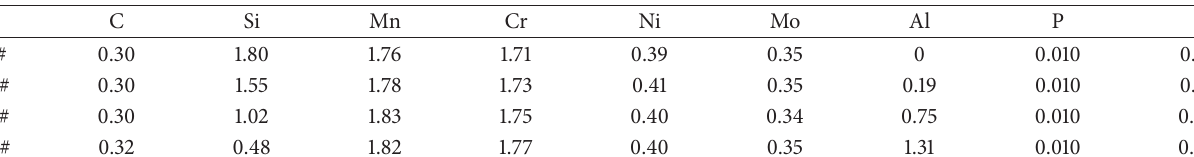
Table 1: Chemical composition of the bainitic steels (wt.%).